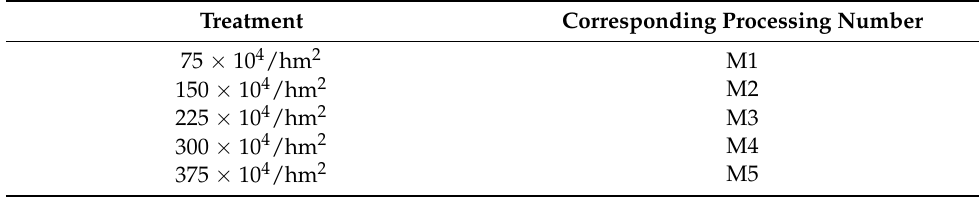
Table 1. Field treatment and corresponding number.